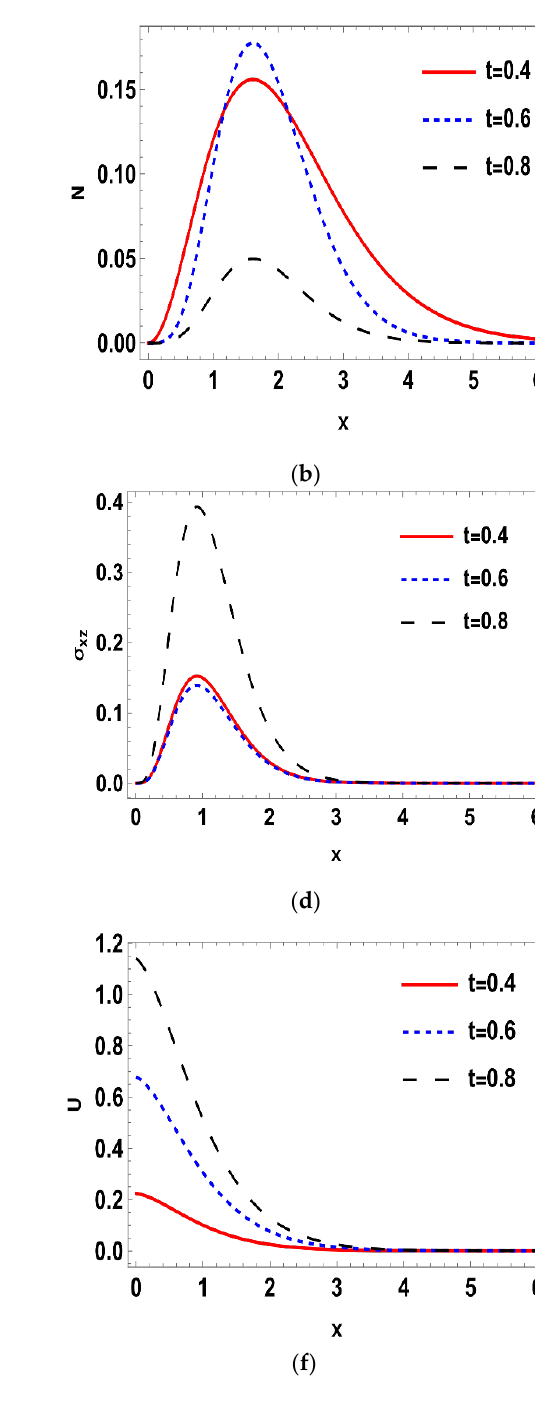
Figure 1. ( a – f ) The deterministic temperature, normal stress, carrier density, displacement and heat conduction distributions along the distance for various values of times in relation to generalized photothermoelasticity theory when 5 a = .